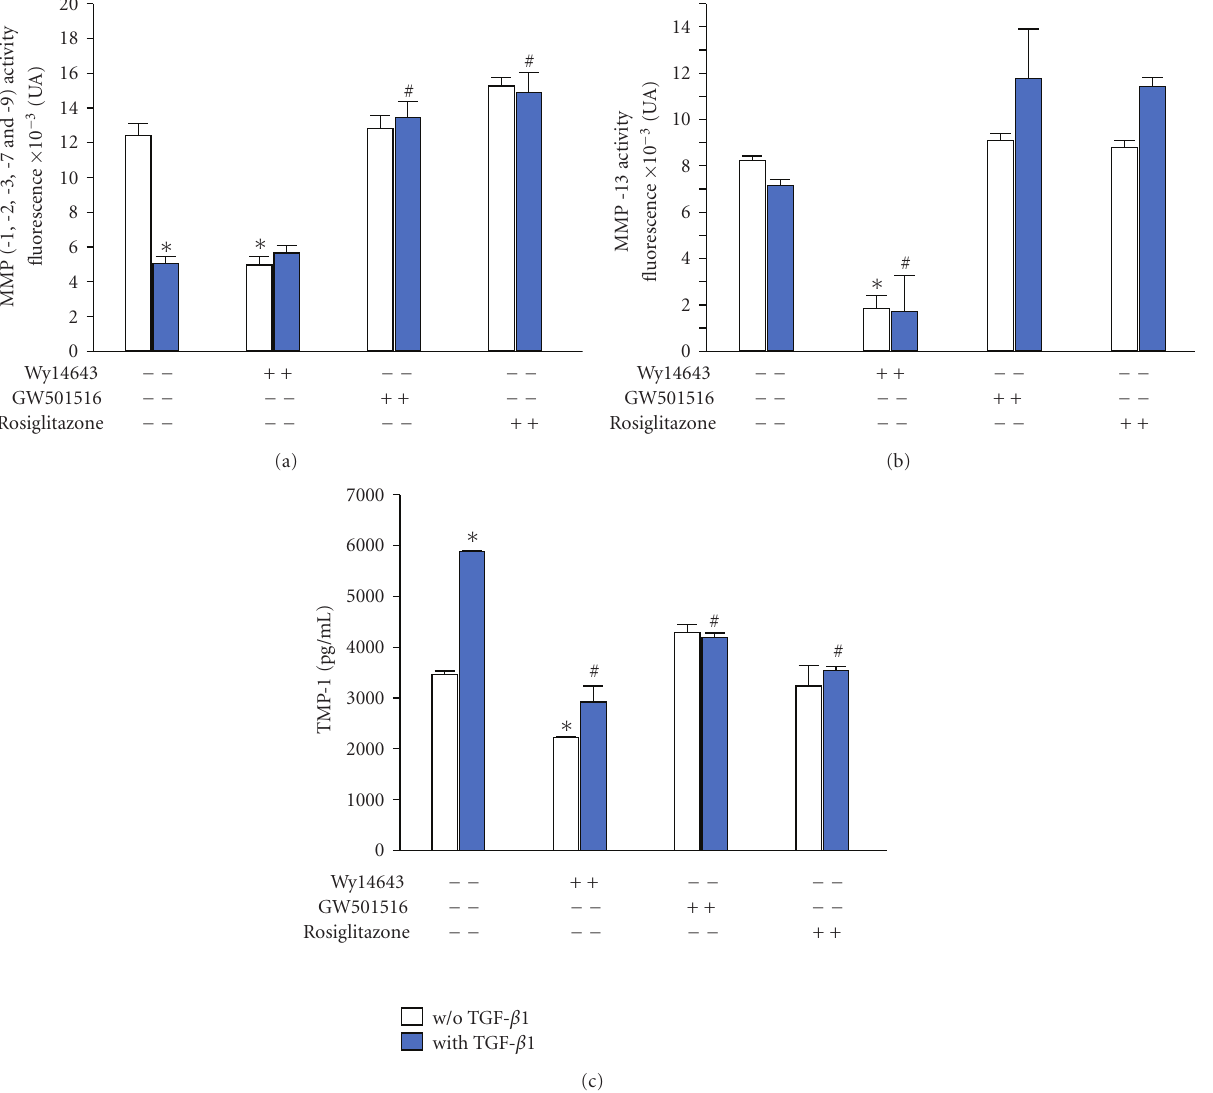
Figure 4: E ff ects of synthetic PPAR agonists on TIMP-1 production and changes of global MMPs (-1, -2, -3, -7, and -9) and specific MMP- 13 activities induced by TGF- β 1 in rat chondrocytes . Chondrocytes, embedded in alginate beads (5.10 4 cells per bead), were exposed to Wy14643 (100 μ M), GW501516 (100nM), or rosiglitazone (10 μ M) for 2 h before stimulation with TGF- β 1 (10ng/mL), in the presence or absence of PPAR agonists, for 72h. (a) Global activity of MMPs (-1, -2, -3, -7, and -9) in culture supernatants by fluorimetric assay ( n = 6); (b) Activity of MMP-13 in culture supernatants by specific fluorimetric assay ( n = 6); (c) TIMP-1 protein levels in culture supernatants by ELISA ( n = 3). Data were expressed as mean ± SEM and statistically significant di ff erences from the control were indicated as ∗ P < . 05 and from TGF- β 1-treated cells as # P < .